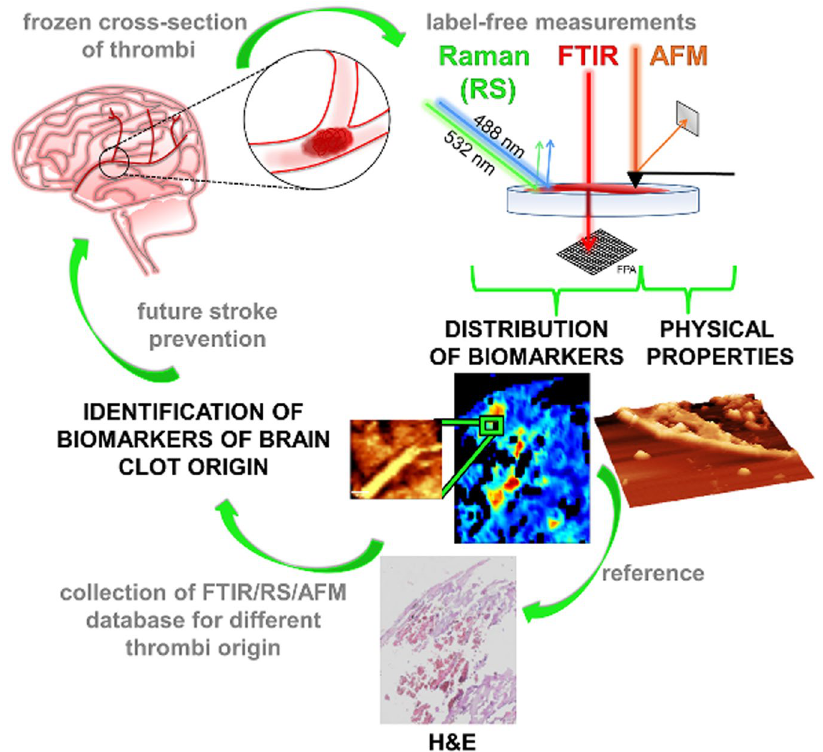
Figure 1. Schematic illustration of acute IS thrombi characterization with the application of FTIR, RS and